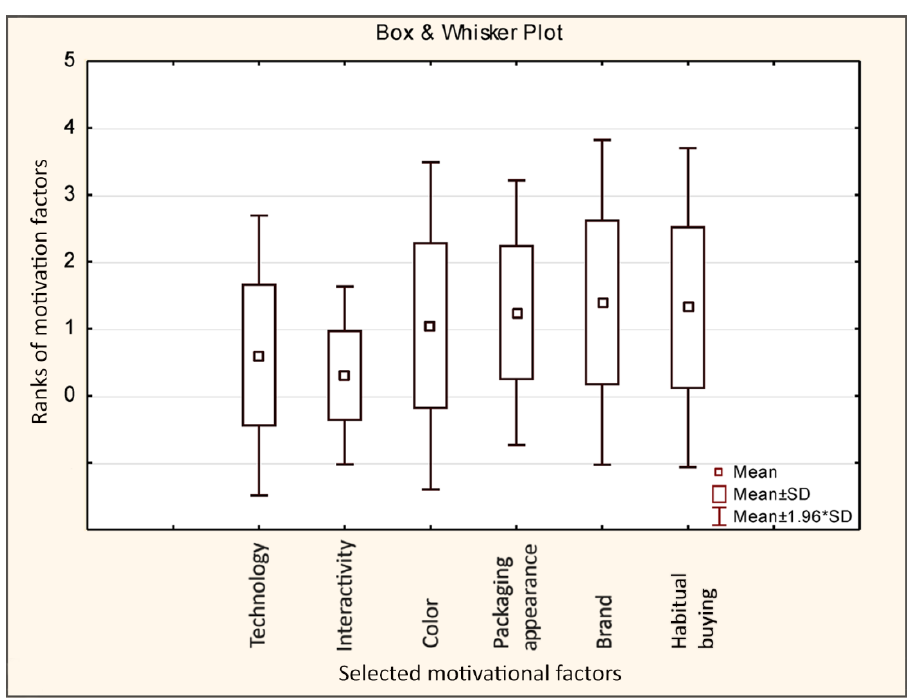
Figure 6. Box & Whisker chart of the motivational factors which most effect the purchase of chocolates on digital media.